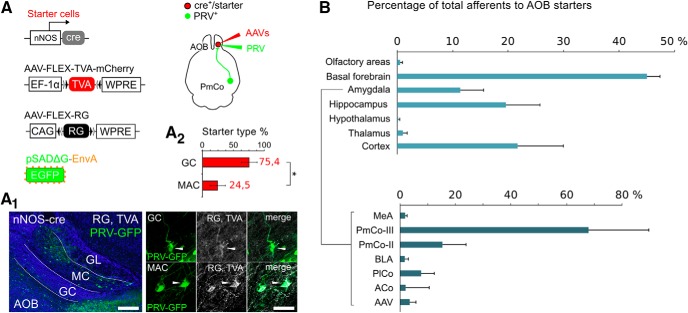
ACPs are synaptically connected to cells in the AOB GC layer. A, Conditional PRV tracing with helper adeno-associated viruses used to identify starter cells in the AOB GC layer. A1, Both GCs and macs are identified as starters (TVA-G/PRV+). A2, Estimate percentage contribution of each cell type (macs or GCs) to the total amount of starter cells in the GC layer (paired t test, p < 0.05). B, The top histograms (light gray) show the percentage of input neurons (PRV labeled) to the AOB GC layer per brain area, referred to the total amount of PRV-labeled neurons in the brain (N = 4 brains). The histogram below (dark gray) show the percentage of input neurons relative to the amount of PRV-labeled neurons within the amygdala only. Layer II and III of the PmCo provide the highest amount of inputs. Scale bars: A1, left, 200 μm; A1, right, 20 μm. GL, glomerular layer; BLA, basolateral amygdala; PlCo, Posterolateral cortical amygdala; ACo, anterior cortical amygdala; aav, anterior amygdala, ventral subdivision.